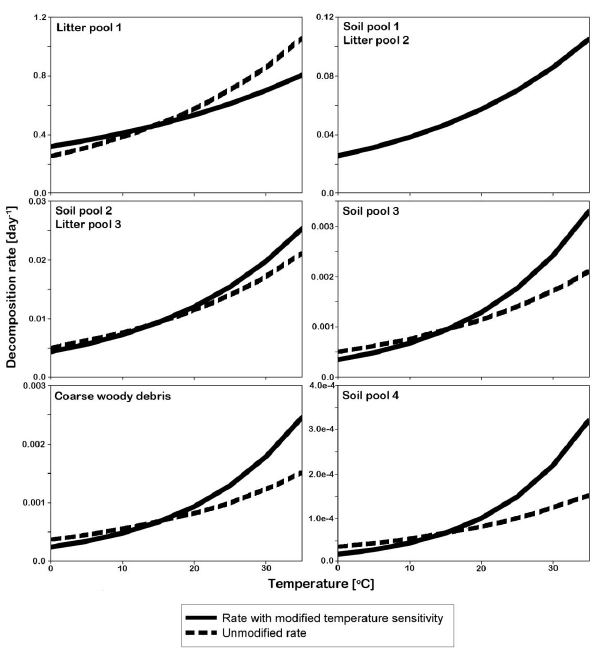
Figure 1. Decomposition rate ( k ) as a function of temperature in the standard Q 10 model (unmodified rate) and the modified model given by Eq. (4). The rates are plotted for all model carbon pools, indicated in the top left of each panel.